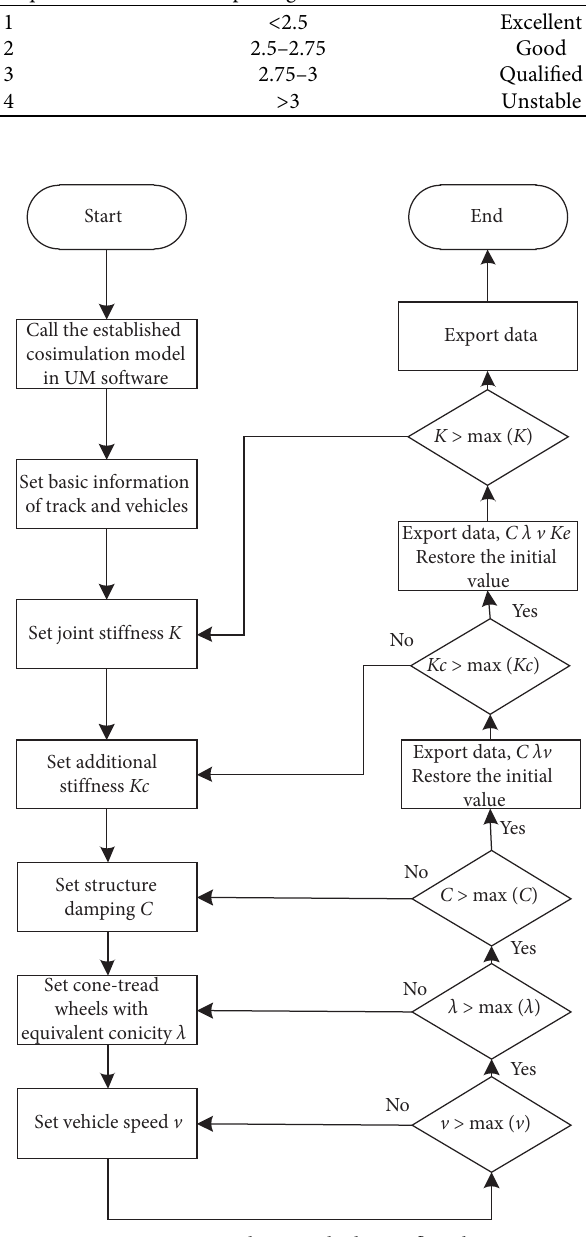
Figure 11: Simulation calculation flowchart.